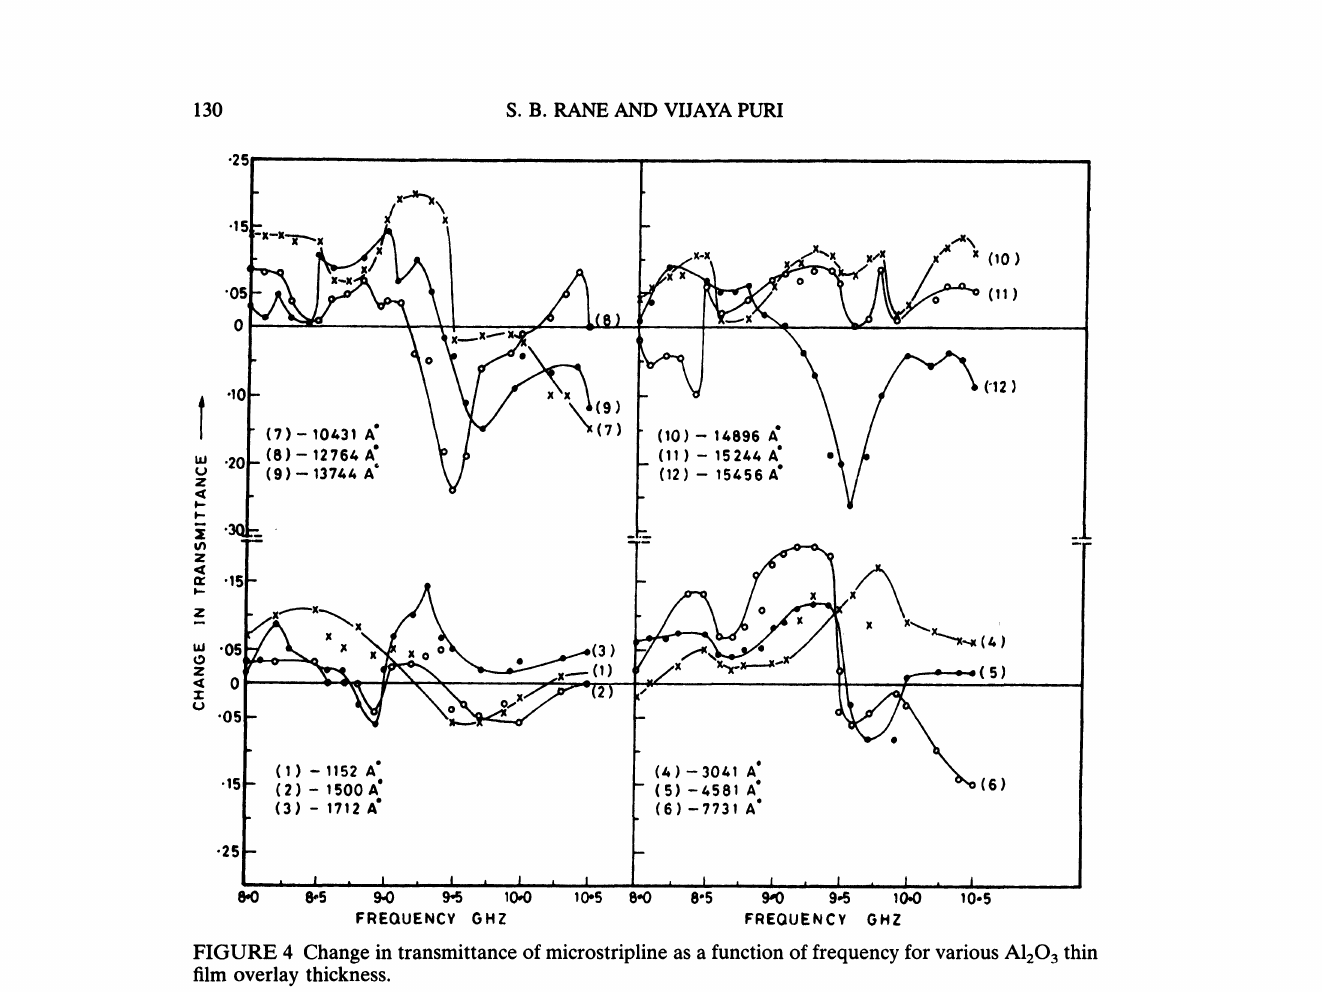
FIGURE 4 Change in transmittance of microstrip]ine as a function of frequency for ,carious A]203 thin film overlay thickness. circuits. The fields associated with the dominant mode would interact with the overlay thereby changing the transmission characteristics of the circuits.